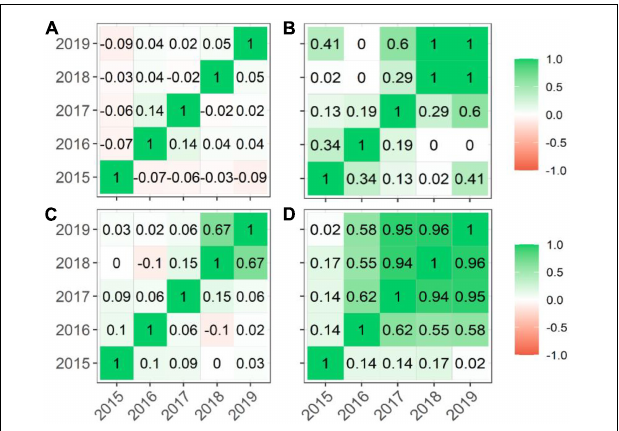
FIGURE 3 | Kendall correlation index for the relationship between fishing activity within each year for all MPAs ( A : multiple-use MPA in the SPSP region; B : no-take MPA in the SPSP region; C : multiple-use MPA in the TMV region; and D : no-take MPA in the TMV region).